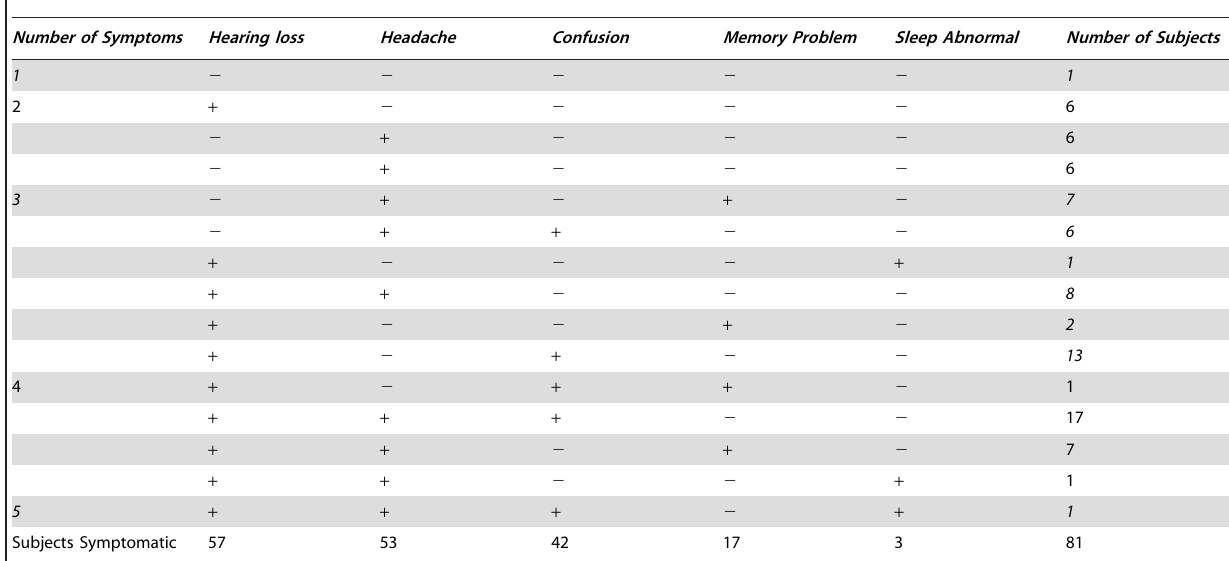
Subjects Symptomatic